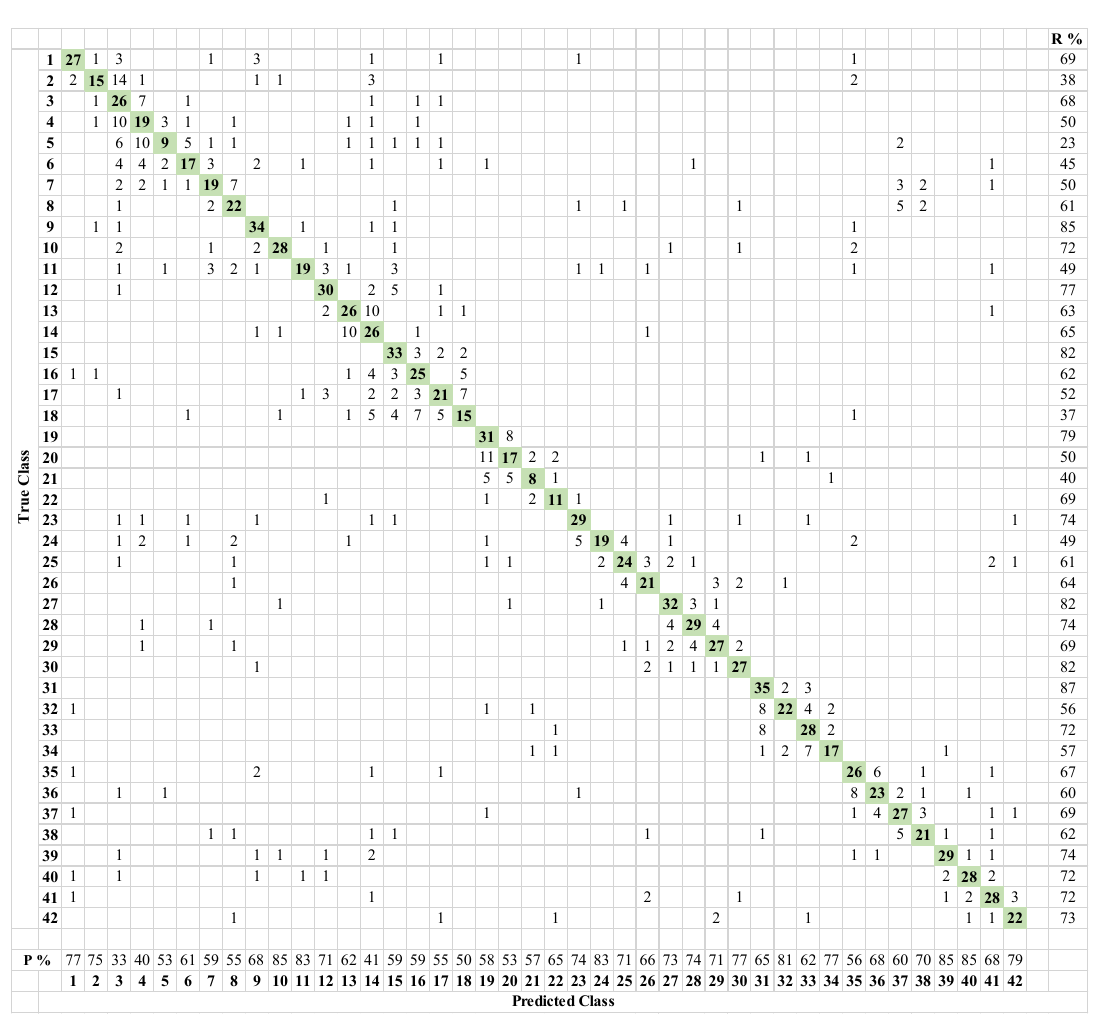
Figure 14. Test confusion matrix of the customized CNN on 10% independent test dataset, 63.71% test classification accuracy. (1: normal; 2–8: unbalance with (6, 10, 15, 20, 25, 30, 35) g mass; 9–12: horizontal misalignment of (0.5, 1, 1.5, 2) mm; 13–18: vertical misalignment of (0.51, 0.63, 1.27, 1.4, 1.78, 1.9) mm; 19–22: overhung position ball fault with (0, 6, 20, 35) g unbalance; 23–26: overhung position cage fault with (0, 6, 20, 35) g unbalance; 27–30: overhung position outer race fault with (0, 6, 20, 35) g un-balance; 31–34: underhung position ball fault with (0, 6, 20, 35) g unbalance; 35–38: underhung position cage fault with (0, 6, 20, 35) g unbalance; 39–42: underhung position outer race fault with (0, 6, 20, 35) g unbalance) (R: Recall, P: Precision).